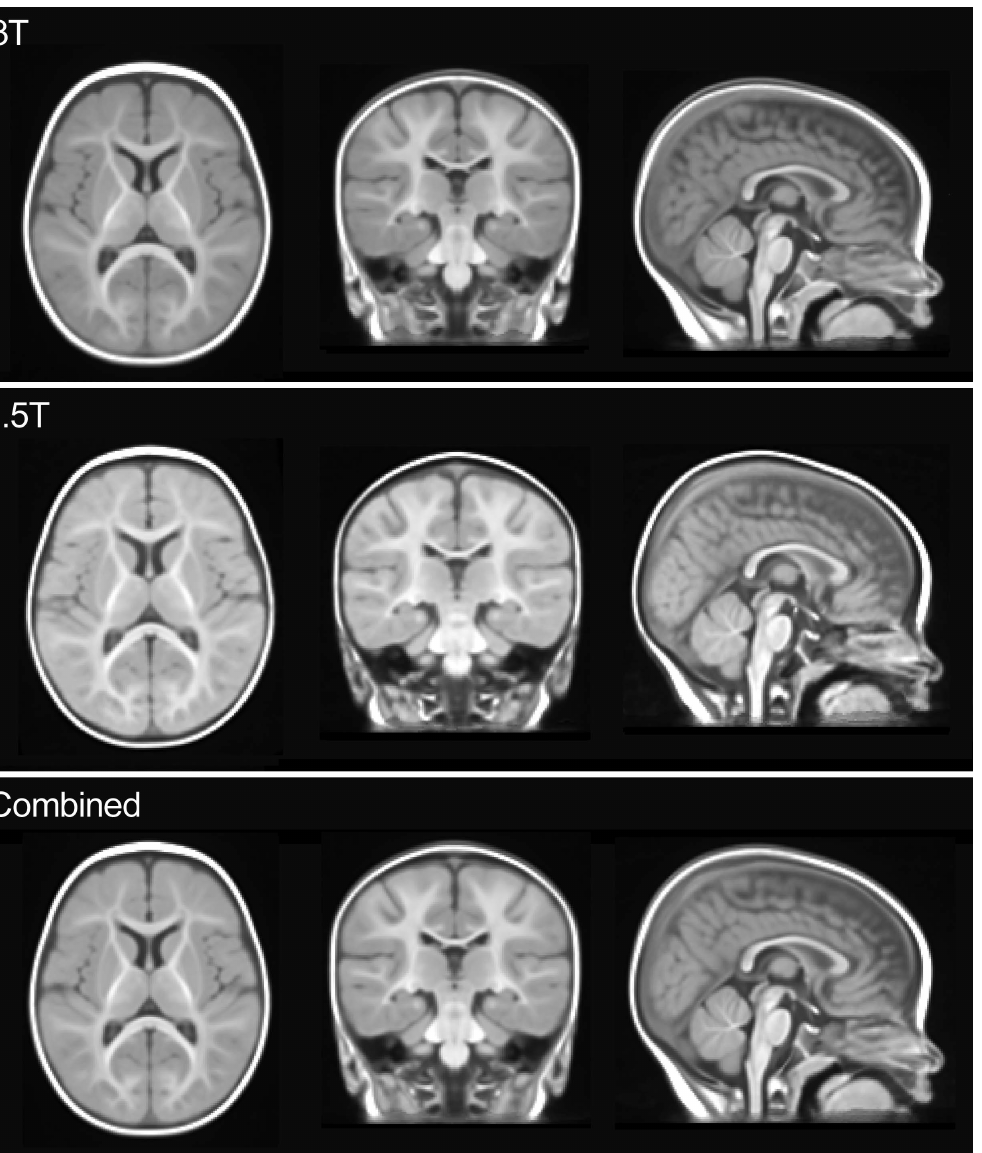
Figure 3. Average head templates. A qualitative comparison of the 3T age-specific 6-month-old infant average (n= 33), the 1.5T age-specific 6- month-old infant average ( n= 27), and the combined age-specific 6-month-old infant average ( n= 60). Sagittal, coronal and axial slices are shown at (97, 116, 79).